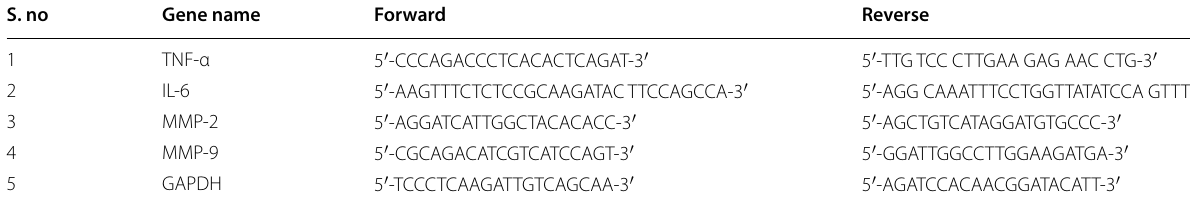
Table 1 List of RT-PCR primers used for the amplification of TNF-α, IL-6, MMP-2 and MMP-9 S. no